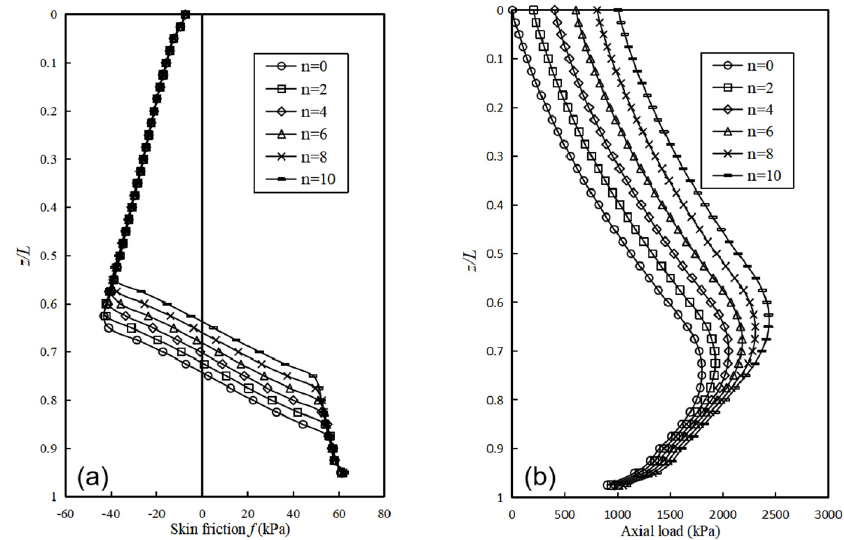
Figure 11. Effect of pressure ratio on ( a ) skin friction ( b ) and axial load.